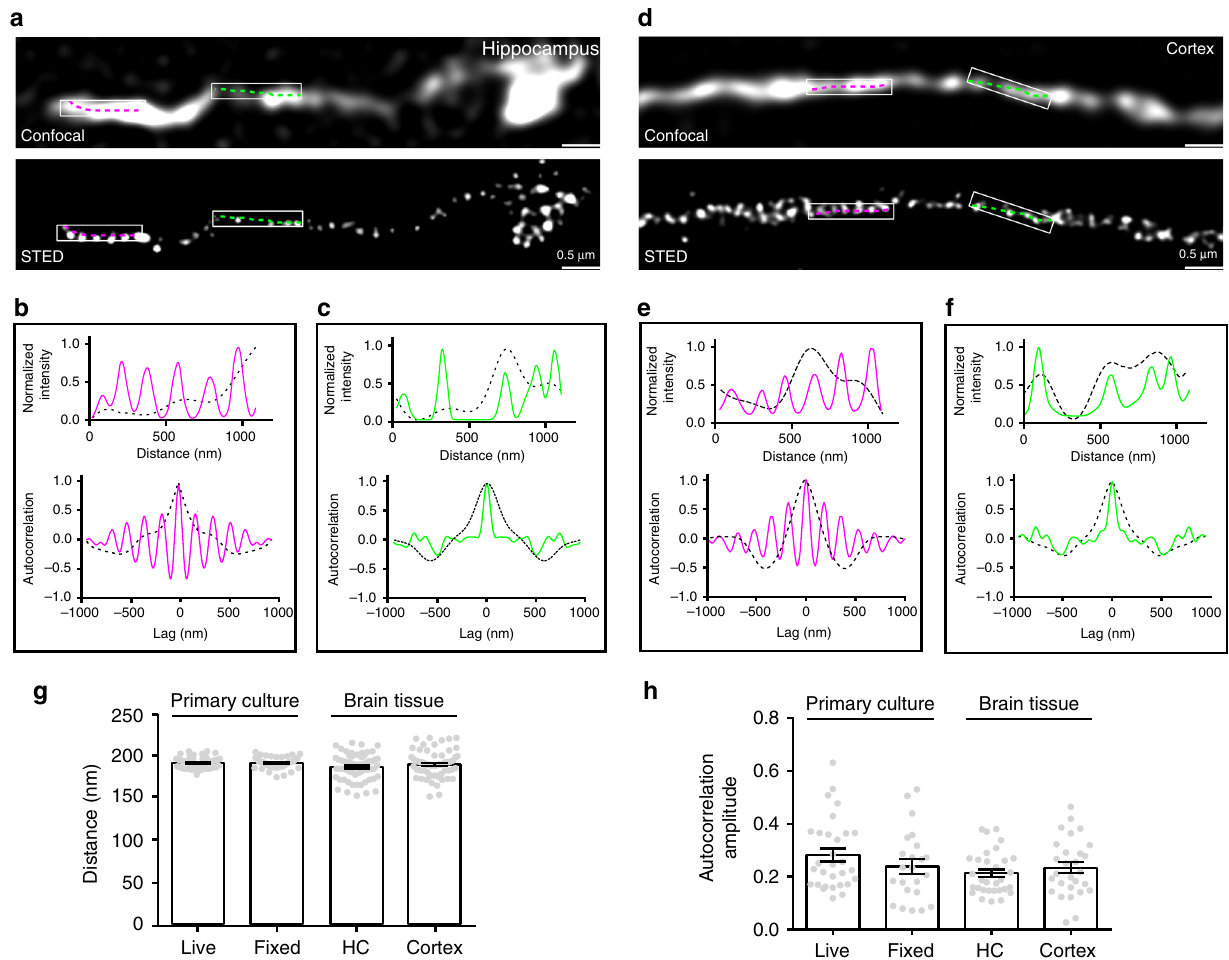
Fig. 1 Periodic hotspots of CB 1 of varying strength in axons from brain tissue. a Representative confocal and corresponding STED images of CB 1 in the hippocampus of mature C57 mice. N = 3 biological replicates. b , c Intensity plotted along the lines in the box regions (top graph). Autocorrelation analysis for the confocal and STED images (bottom graph). d – f Similar to ( a – c ), but in the cortex region of mature C57 mice. N = 3 biological replicates. g Histogram of CB 1 spacing in different samples, live and fi xed hippocampal neurons, brain tissue of the hippocampus (HC) and cortex. Data are mean ± s.e. m. ( N = 3 biological replicates; 70 – 120 axonal regions were examined per condition). p = 0.09, (no signi fi cance), one-way ANOVA. Actual spacing (from left to right), 192 ± 0.8 nm, 192 ± 0.8 nm, 187 ± 2 nm, 190 ± 2 nm. h Amplitude of the average autocorrelation functions calculated from randomly selected axon segments in different samples. p = 0.13 (no signi fi cance), one-way ANOVA. Actual autocorrelation amplitude (from left to right), 0.28± 0.02, 0.24 ± 0.03, 0.21 ± 0.01, 0.23 ± 0.02. Data in ( g , h ) are mean ± s.e.m. ( N = 3 biological replicates; 70 – 120 axonal regions were examined per condition).